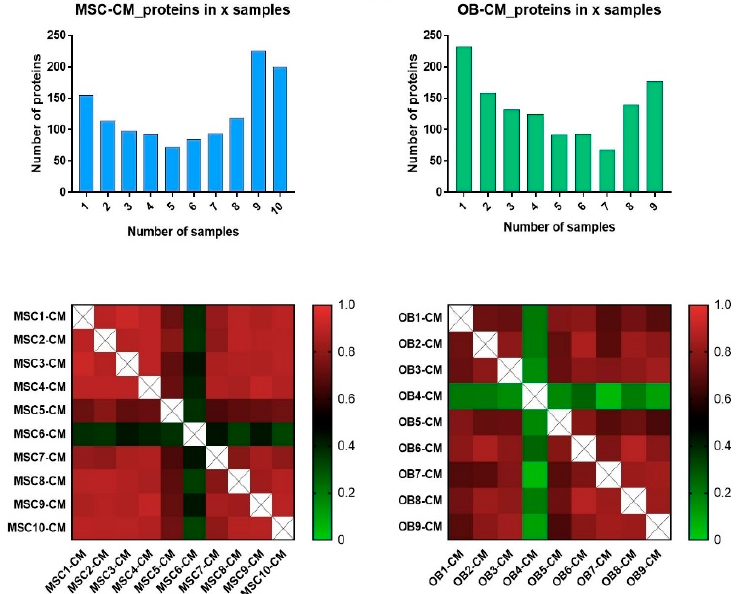
Figure 1. The constitutive protein release by normal MSCs and osteoblasts; a qualitative proteomic comparison of the various MSCs (10 donors) and osteoblast donors (OB, nine donors). Cells were cultured in serum-free medium for 48 h before supernatants were harvested and the protein levels analyzed in the culture supernatants. The upper two bar plots show the number of proteins ( y -axis) that could be quantified for only one donor and up to all ten/nine donors/samples, ( x -axis) for the MSCs ( upper left ) and osteoblasts ( upper right ). The lower part of the figure shows Pearson correlation plots based on the proteins that could be quantified for at least five donors/samples when analyzing the 10 MSC donors ( lower left ) and nine osteoblast donors ( lower right ).